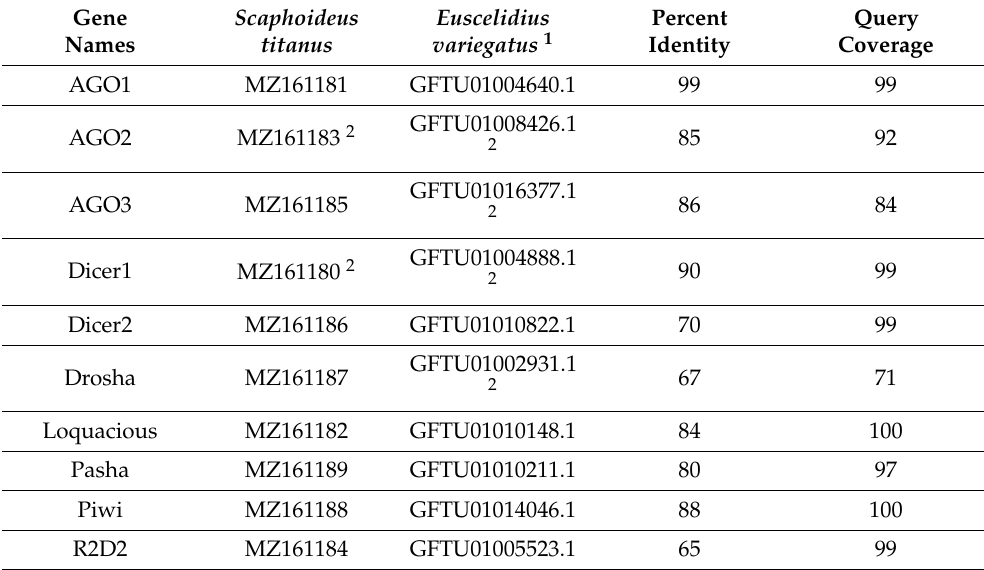
Table 1. Names and NCBI accession numbers of the genes involved in the insect RNAi pathways. Percentages of sequence identities and query coverage between Scaphoideus titanus RNAi pathway proteins and the corresponding proteins from Euscelidius variegatus are